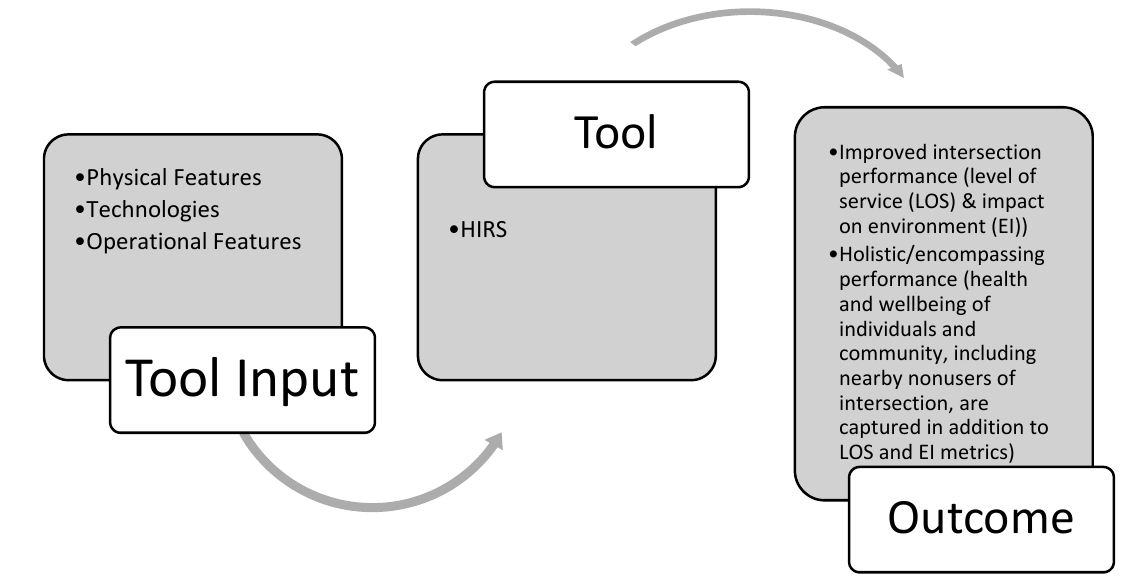
Figure 1. HIRS conceptual implementation framework.